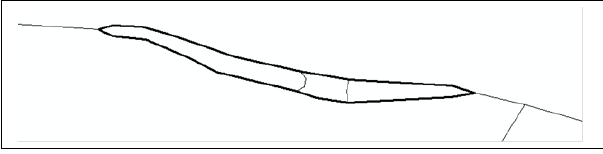
Figure 1. A dual line structure connecting road